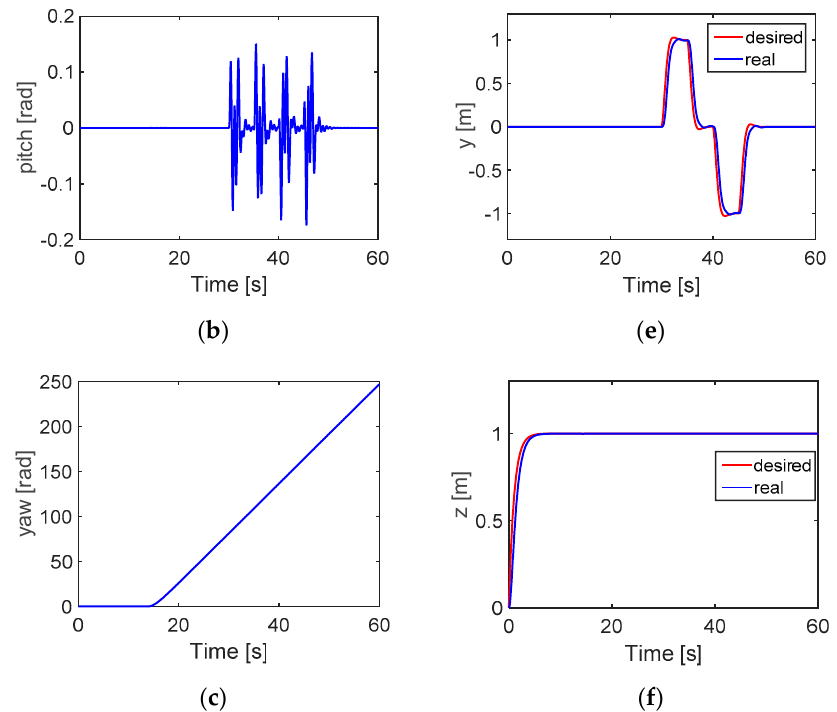
Figure 11. Attitude angles and position response for scenario 2: ( a ) Roll angle, ( b ) Pitch angle, ( c ) Yaw angle, ( d ) x-direction, ( e ) y-direction, and ( f ) z-direction.